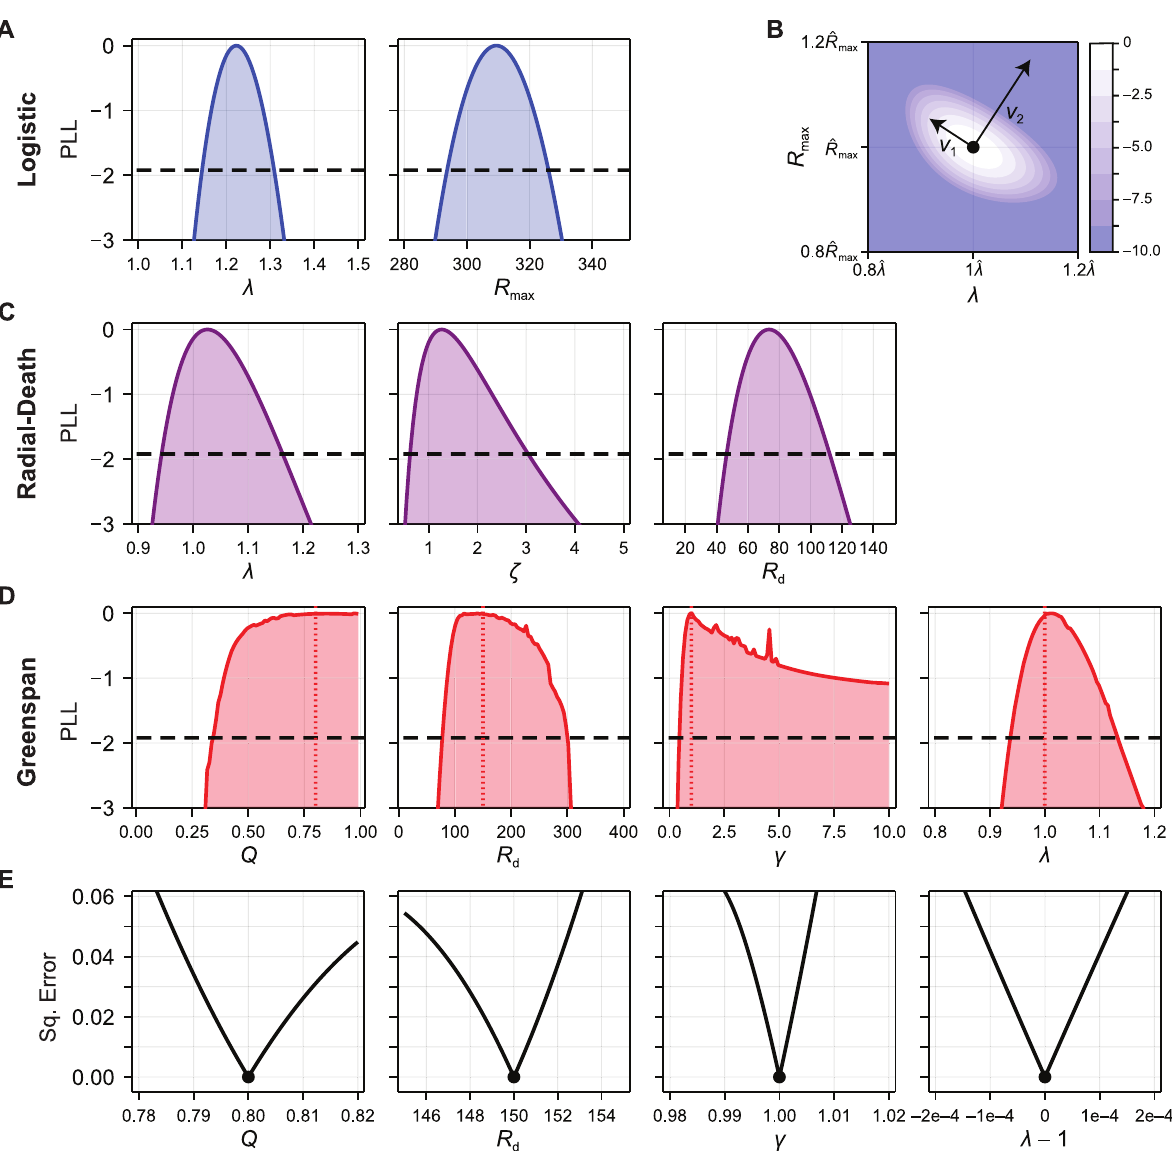
Fig 5. Identifiability analysis for the logistic, radial-death, and Greenspan models. (A,C,E) Profile likelihood for the parameters in each model, using synthetic data generated from the Greenspan model with standard deviation σ = 20 μ m. Also shown is the threshold for an approximate 95% confidence interval (black-dashed). Decreasing the confidence level (i.e. from 95% to 99%) lowers this threshold. For the Greenspan model, we additionally show the parameter values used to generate the synthetic data. (E) Shows the profiled error function for each parameter in the Greenspan model. Note that profiles of the error function are produced in the case of noise-free data. (B) Normalised log-likelihood surface for the logistic model, showing the maximum likelihood estimate (black dot) and both eigenvectors of the Fisher information matrix. v 1 corresponds to the eigenvector with the smallest eigenvalue. Note that axes are scaled relative to the maximum likelihood estimate ð ^ l ; ^ R